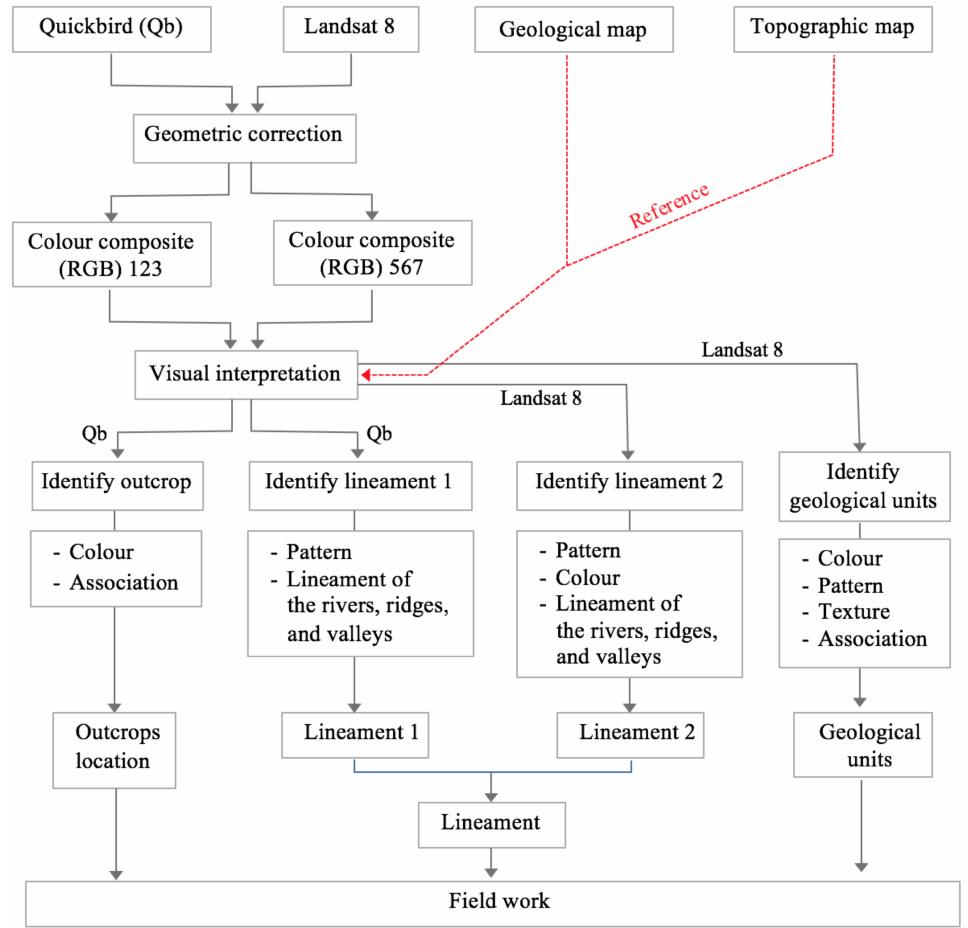
Figure 6. Pre-fieldwork